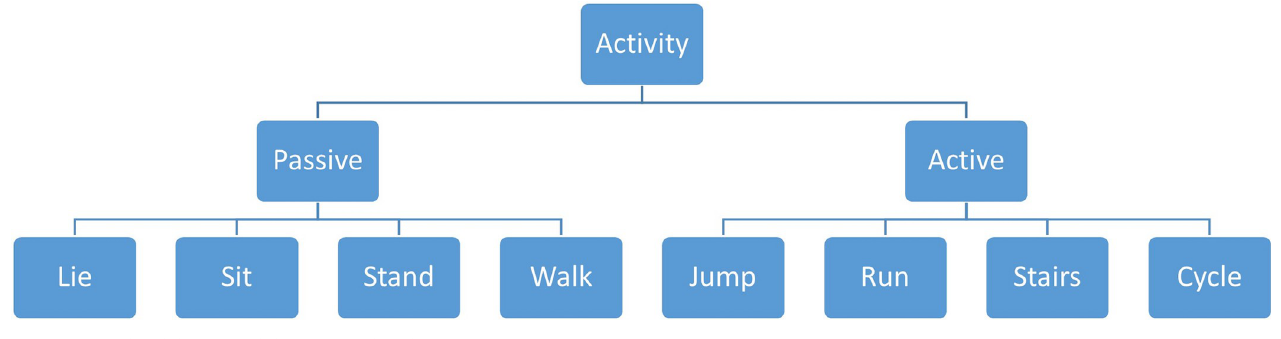
Fig 3. Hierarchical diagram of the activity